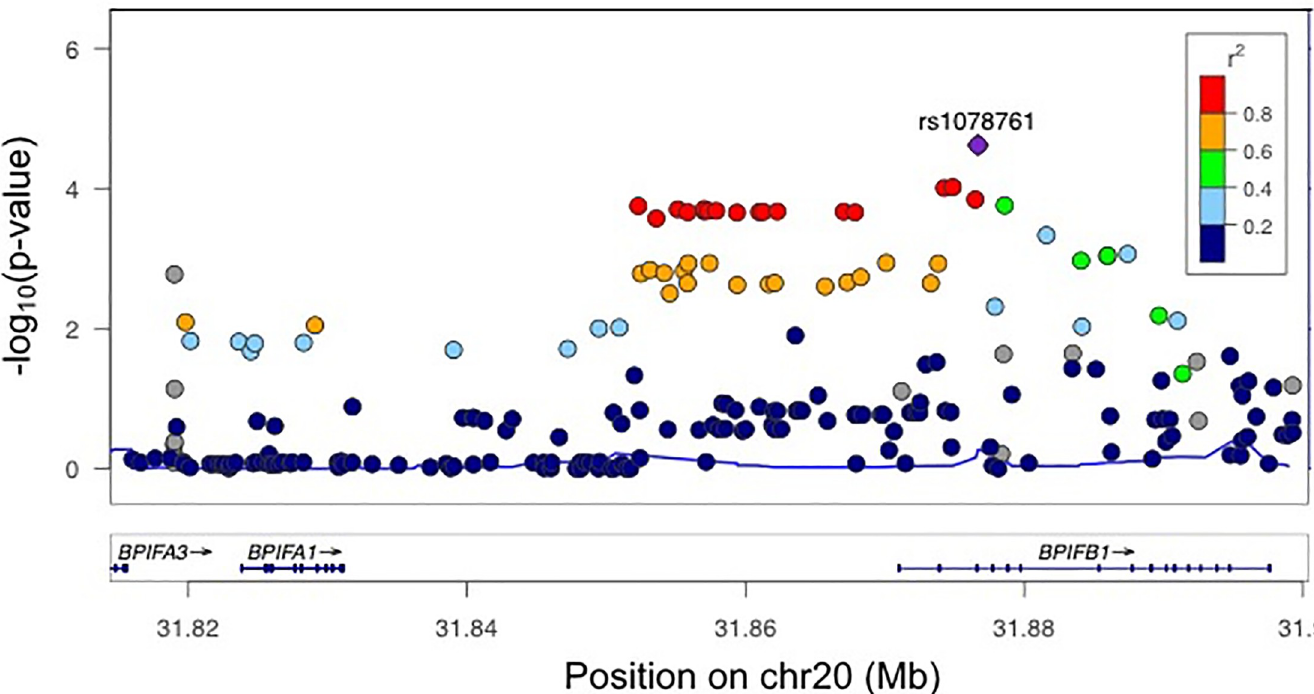
Fig 1. Locus zoom plot of the region 10 kb upstream of BPIFA1 to 10 kb downstream of BPIFB1 . The y axis shows P values in the–log 10 scale for polymorphisms that were tested for association in the meta-analysis of 6365 CF patients for lung disease severity. rs1078761 remained the most significant association in the region (purple diamond). The extent of linkage disequilibrium (measured by the r 2 statistic) with rs1078761 for the remaining SNPs is indicated with colors.